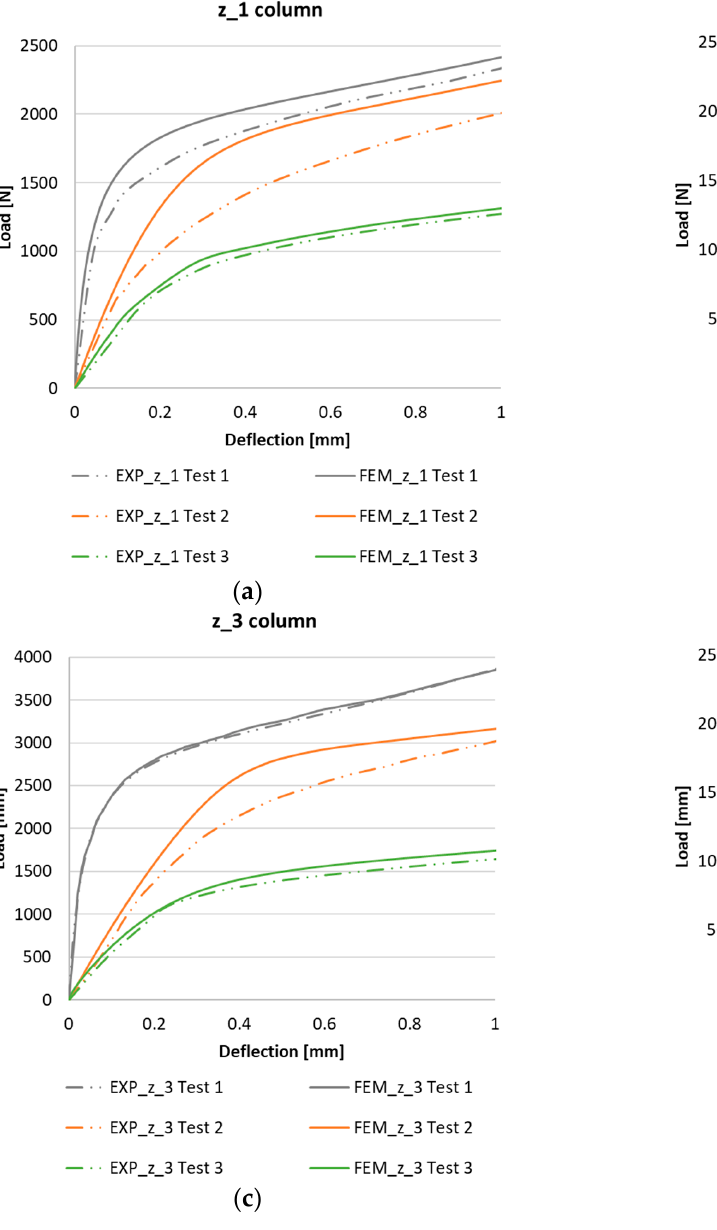
Figure 6. Postcritical EXP-FEM equilibrium paths in the realization of compressive load eccentricity: